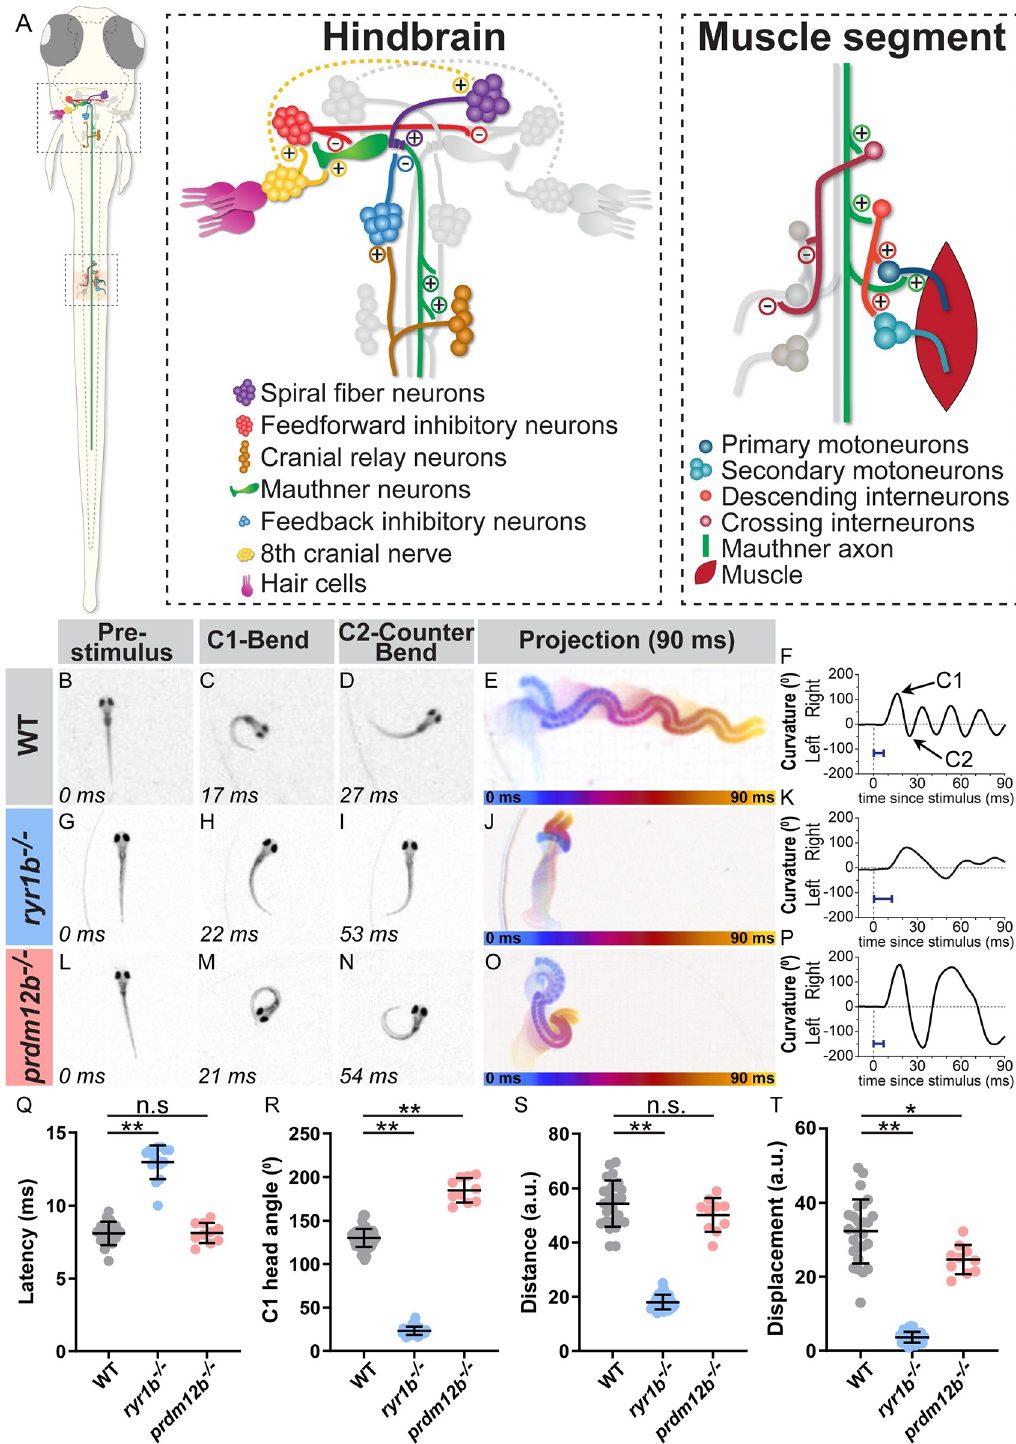
Fig 1. The zebrafish larval startle response is amenable to circuit and genetic analysis. ( A) The acoustic startle response is driven by an action potential from the Mauthner neuron (green), which activates motor neurons in the spinal cord to drive a contralateral body bend. Excitatory and inhibitory neurons in the hindbrain and in the spinal cord impinge upon the Mauthner cells to ensure motor neurons fire on only one side. (B-F) A representative acoustic startle response in a 5 dpf (days post fertilization) wild type larva. An acoustic stimulus is delivered at 0 ms (B), which elicits a rapid turn (C) followed by a